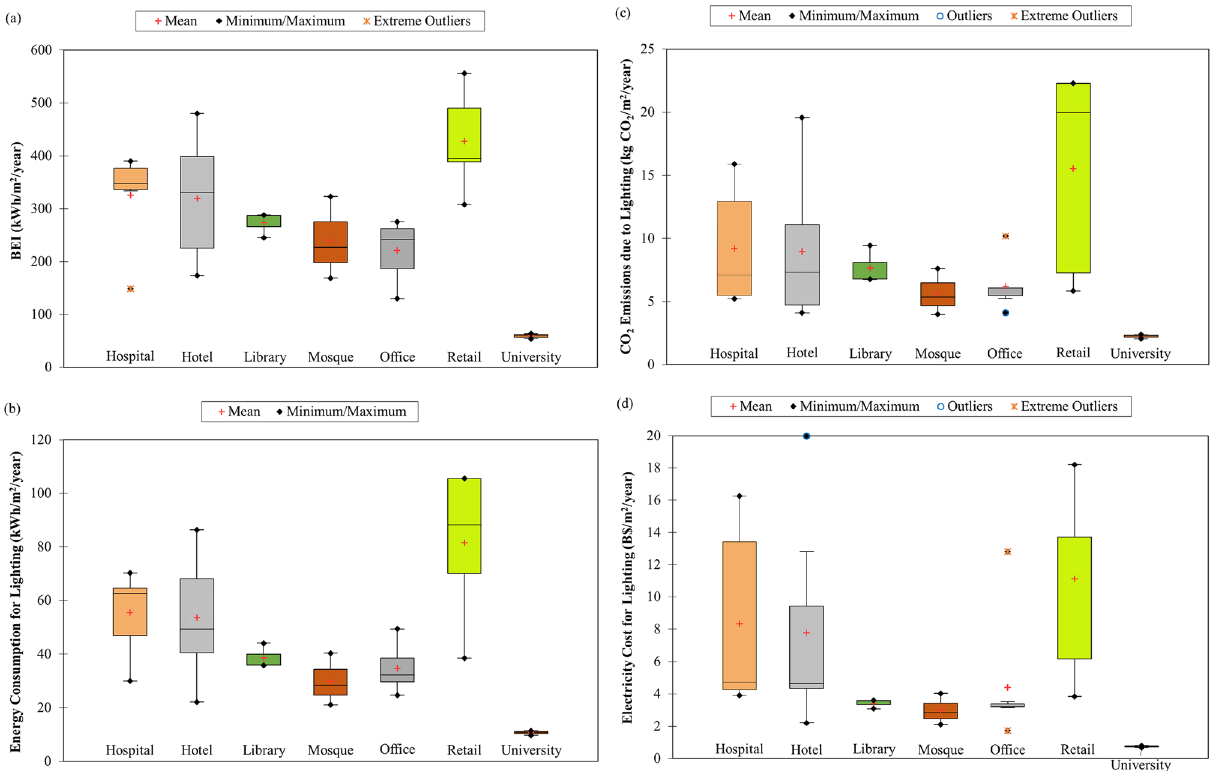
Figure 1. Box plots of (a) building energy intensity (BEI), (b) energy consumption, (c) CO 2 emissions and (d) electricity cost of lighting for different types of commercial buildings in Southeast Asia.